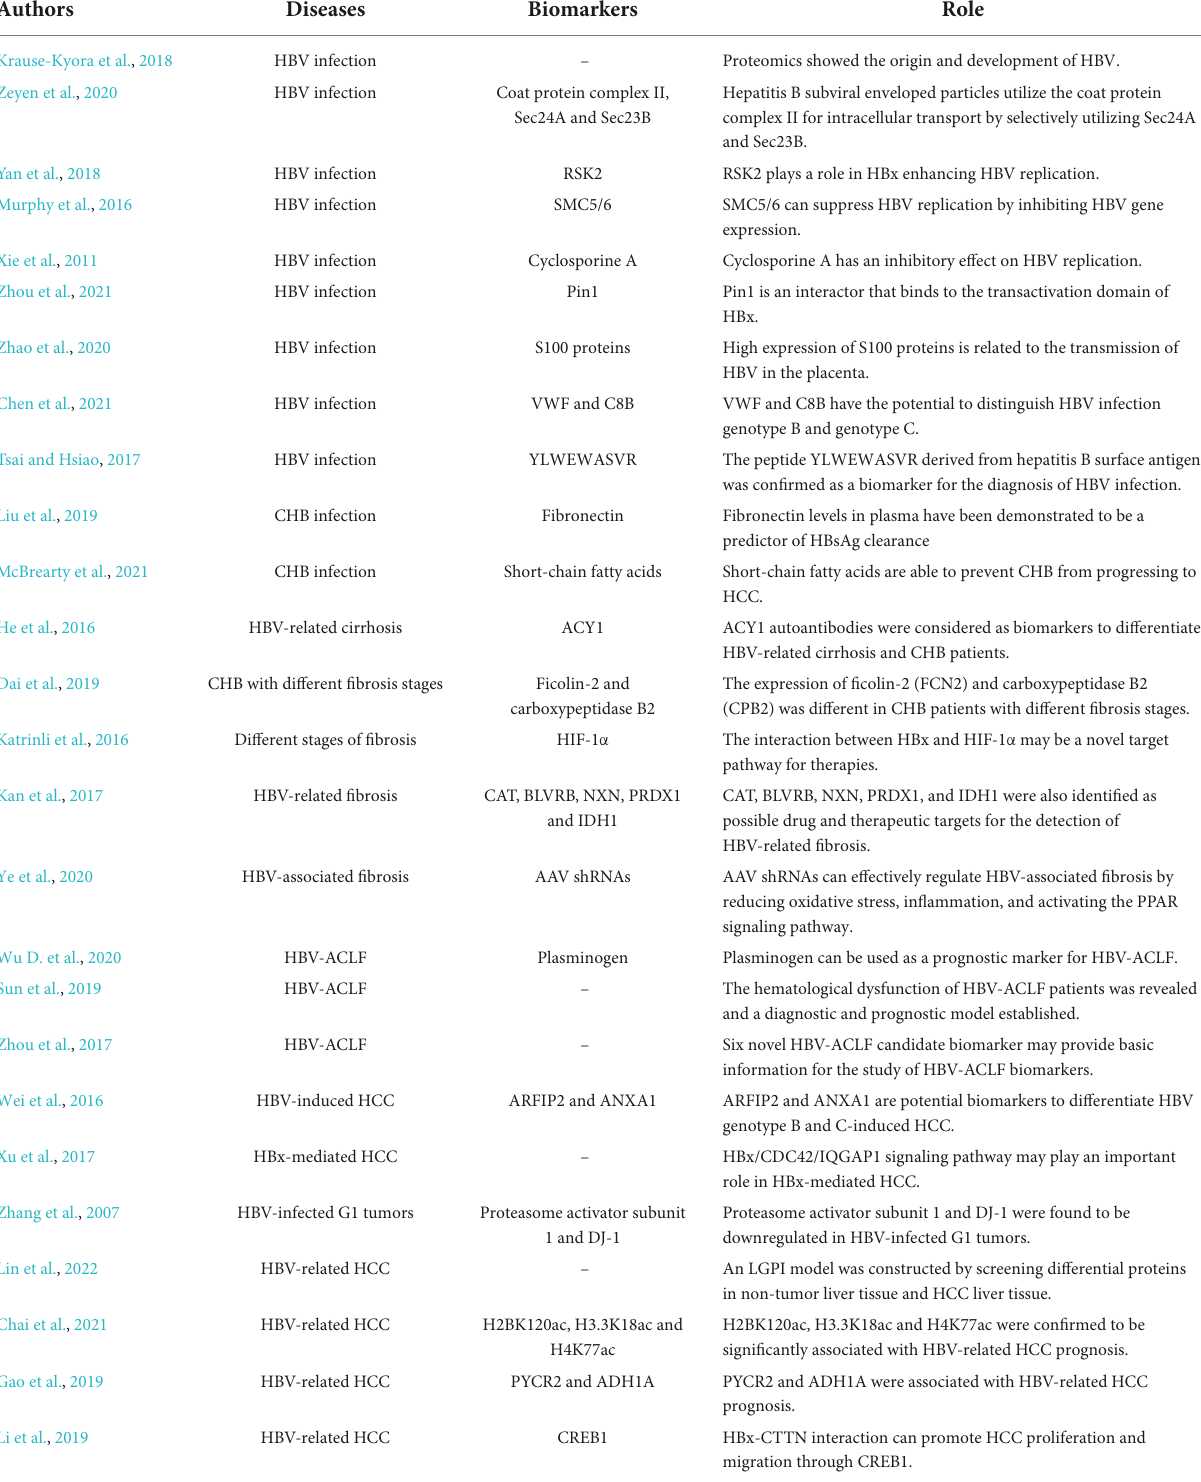
TABLE 1 The applications of proteomics in hepatitis B and related